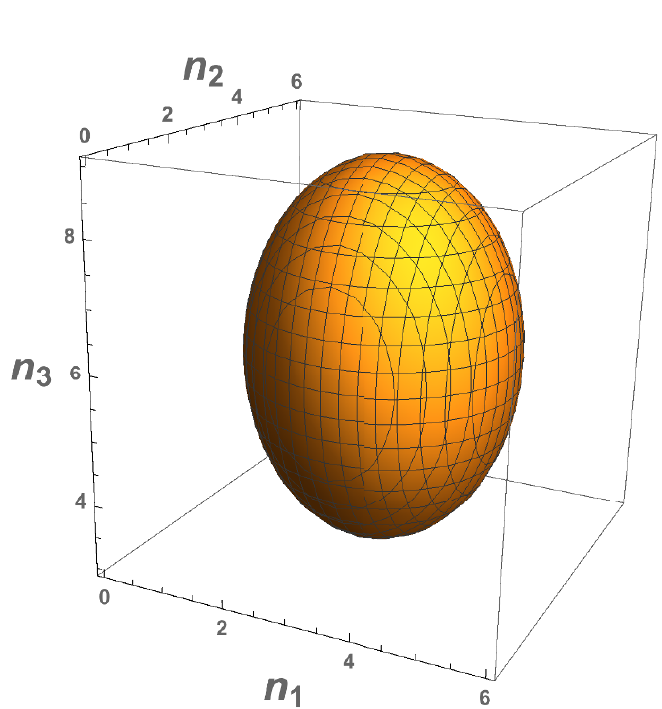
Figure 7 . Minkowski solutions for the three-(cid:12)eld model with (cid:11) 1 = 2, (cid:11) 2 = 2 and (cid:11) 3 =